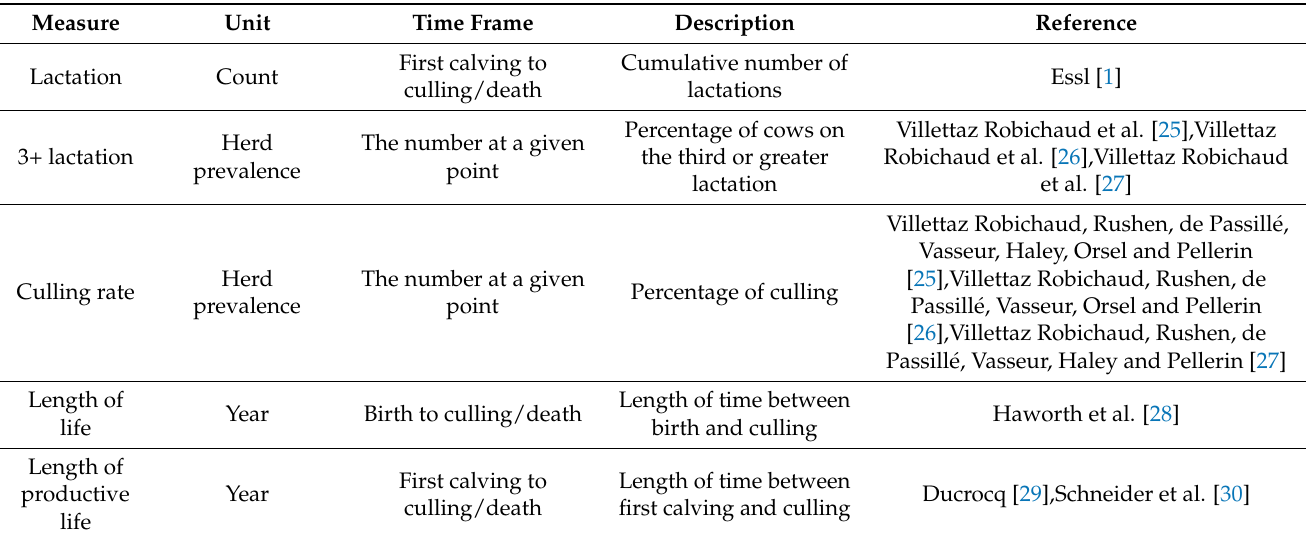
Figure 2. Schematic representation of the life of a dairy cow according to a chronological sequence of key events (conception, birth, weaning, first calving, and culling/death) that prompt a change to the different life status (fetus, calf, heifer, and adult cow) and respective life stages (fetal, early, and productive life). The length of the arrows is proportional to the duration of each status and stage as seen in the province of Quebec, Canada [24]. Table 1. Dairy cow longevity metrics commonly